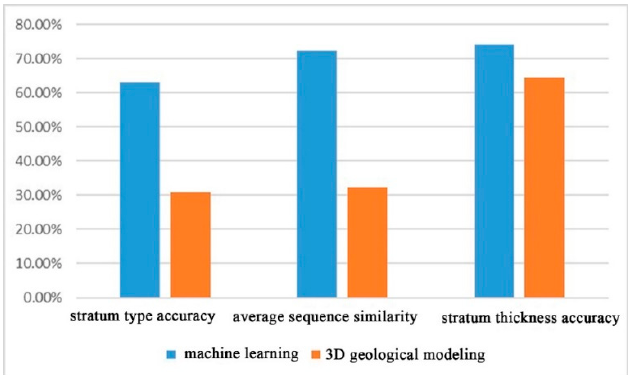
Figure 42. Comparison histogram of the prediction results of machine learning and 3D geological modeling.